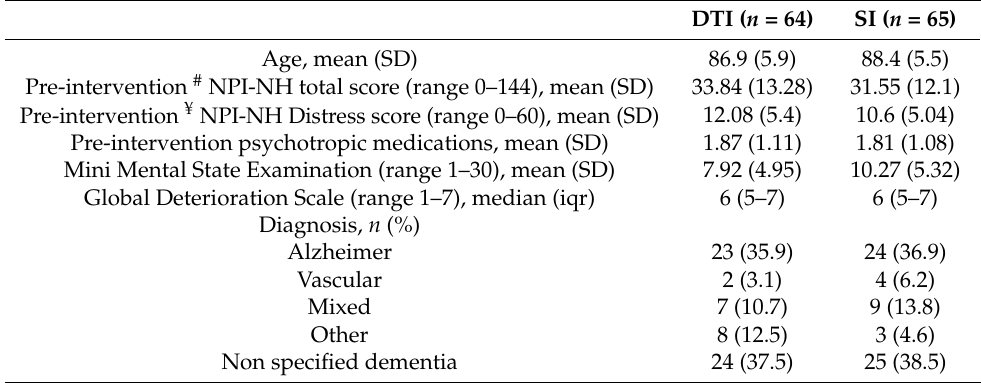
Table 1. Baseline sociodemographic and clinical characteristics by